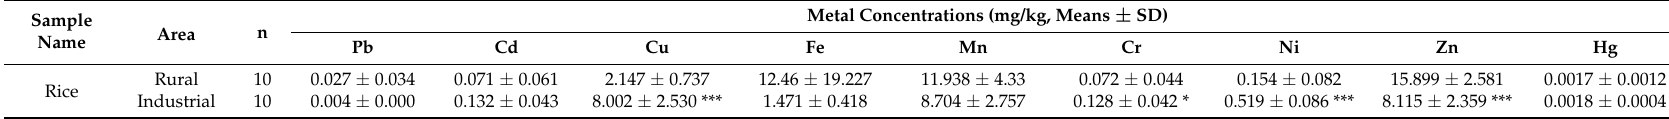
Table 3. Metal concentrations in